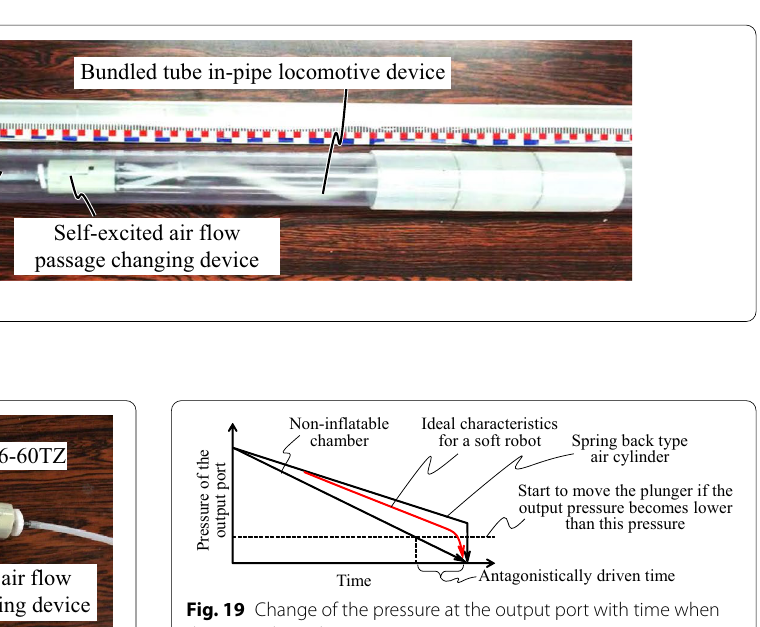
Fig. 19 Change of the pressure at the output port with time when the air is